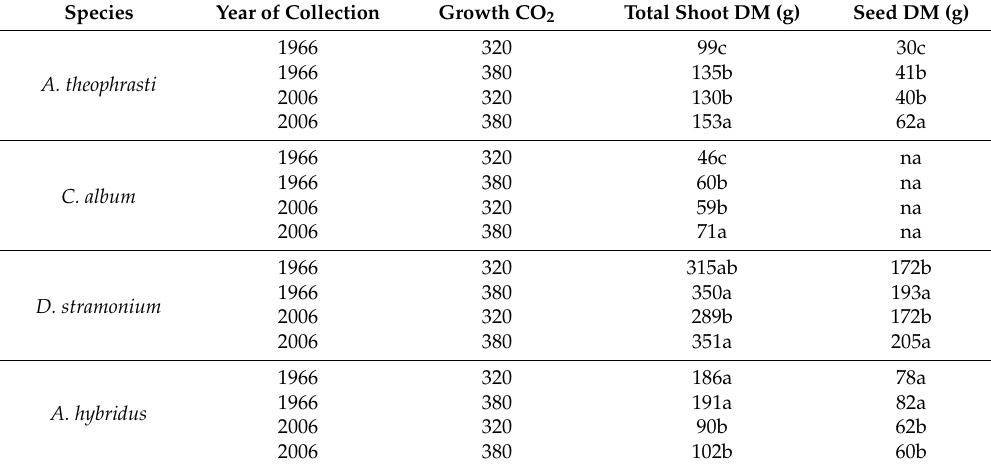
Table 2. Total shoot dry mass (DM) and seed dry mass at seed maturity in four species from two years of seed collection, when grown at two CO 2 concentrations (mol mol − 1 ). Within species, values followed by different letters were different at p = 0.05, based on analysis of variance. na indicates not